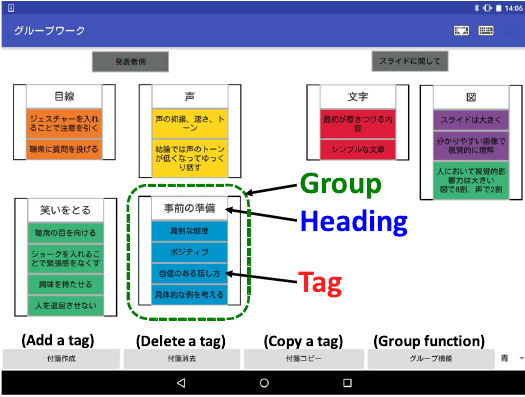
Fig. 15 Screenshot of the educational application (in